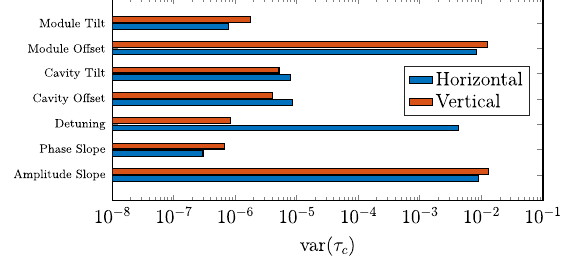
FIG. 12. Single-parameter variance of τ c , calculated for 5 subsamples each, for the horizontal (blue) and vertical plane (red). Amplitude slope of the accelerating field and the offset of the module clearly dominate the variation of τ c . The detuning only impacts the horizontal plane. Note that the plotted results strongly depend on the defined parameter